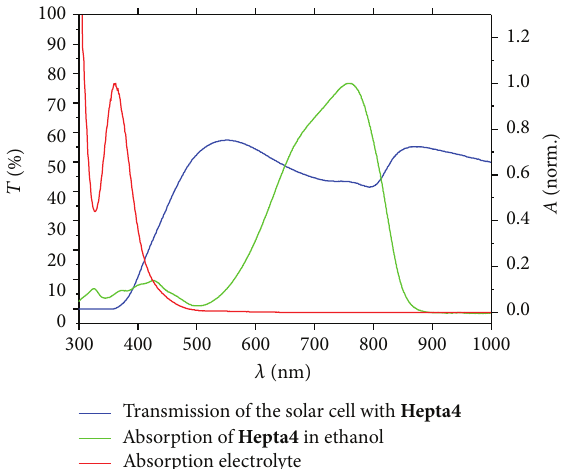
Figure 3: Transmission of large-area DSC with NIR dye.